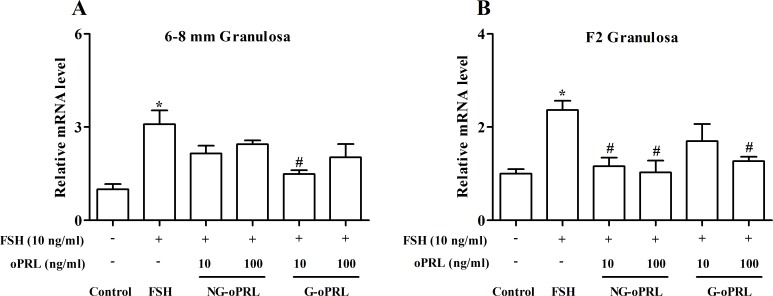
Effects of non-glycosylated (NG-) and glycosylated (G-) ovine PRL (oPRL) (0, 10 or 100 ng/ml) on FSH-mediated PRLR mRNA expression in cultured granulosa cells of the 6–8 mm (A) and F2 (B) follicles after a 24-h culture. Relative expression level was normalized to 18S rRNA. Data are expressed as fold differences ± SEM of three independent experiments using tissues from different hens and are compared to control cells of each follicular class. *, P < 0.05 compared to control cells; #, P < 0.05 compared to cells only stimulated by 10 ng/ml FSH.